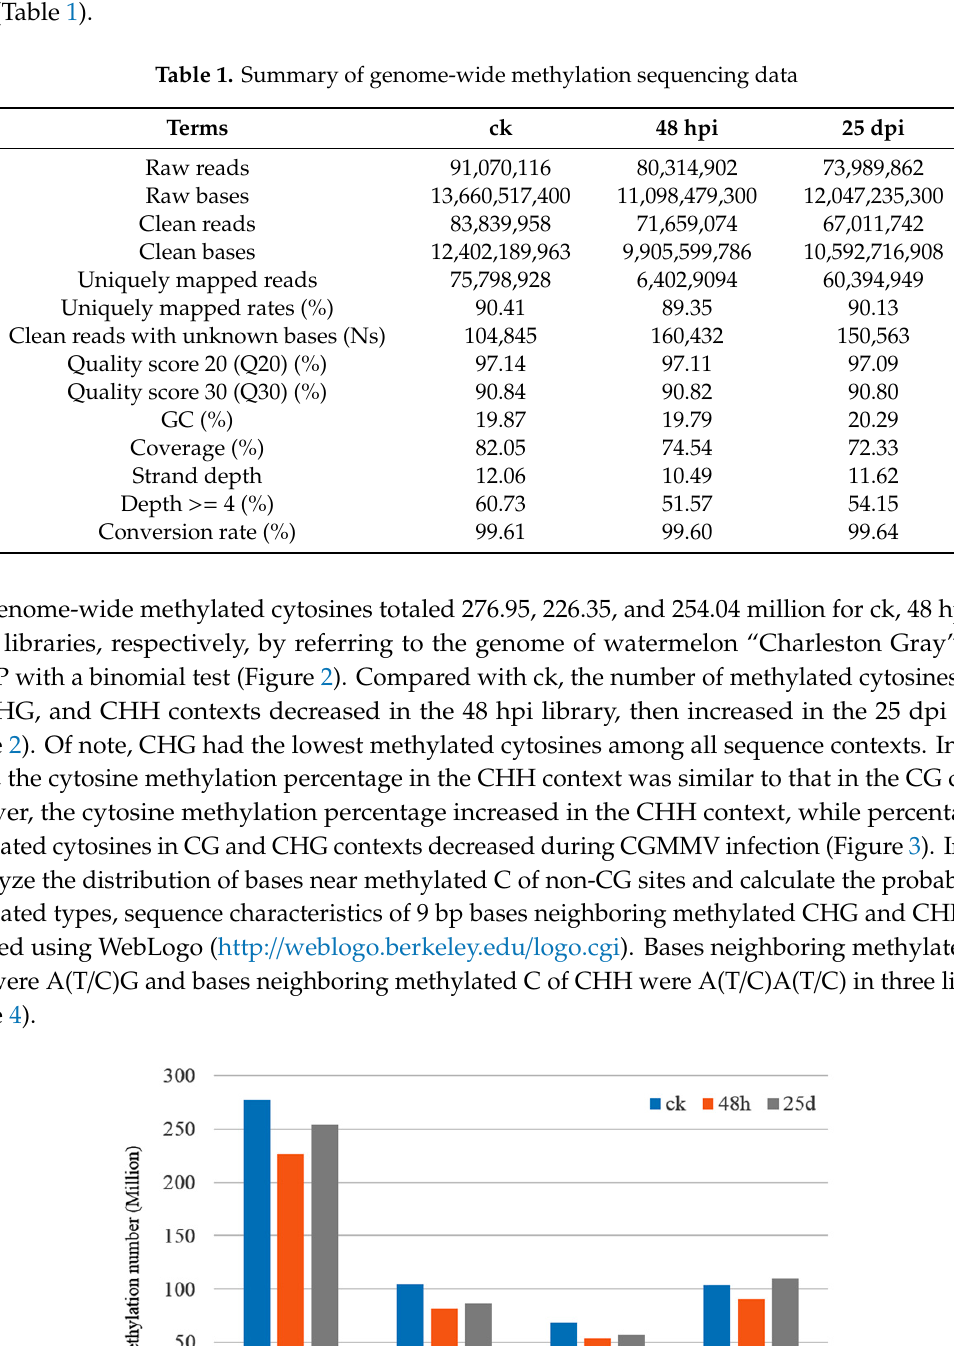
Table 1. Summary of genome-wide methylation sequencing data